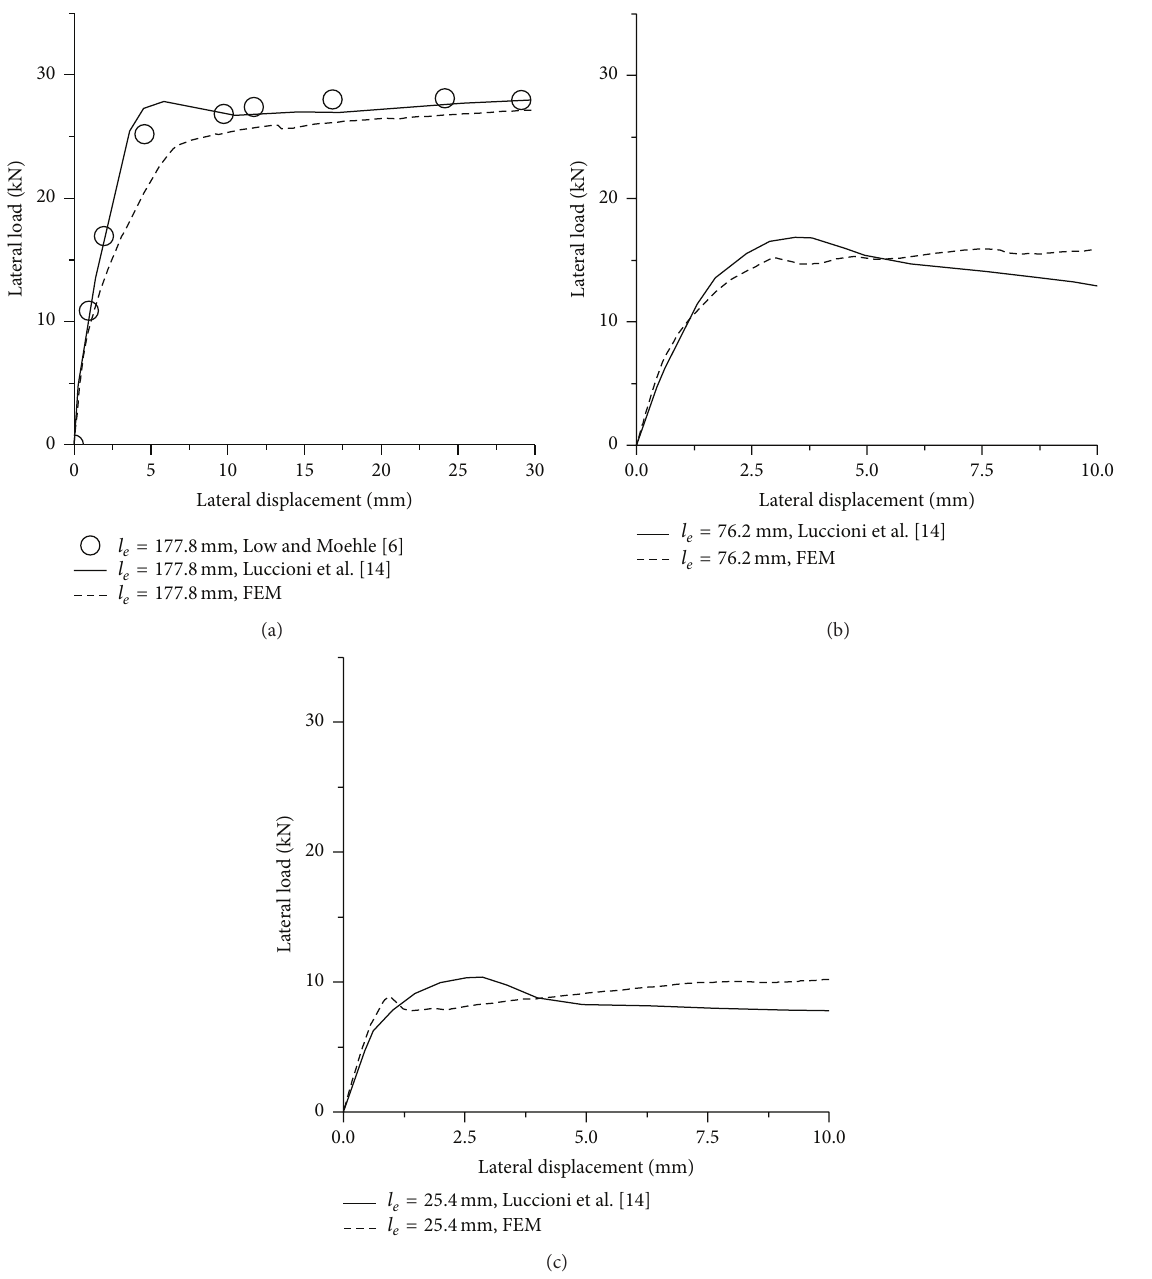
Figure 6: Verification results: (a) 𝑙 𝑒 = 177.8 mm; (b) 𝑙 𝑒 = 76.2 mm; and (c) 𝑙 𝑒 = 25.4 mm.